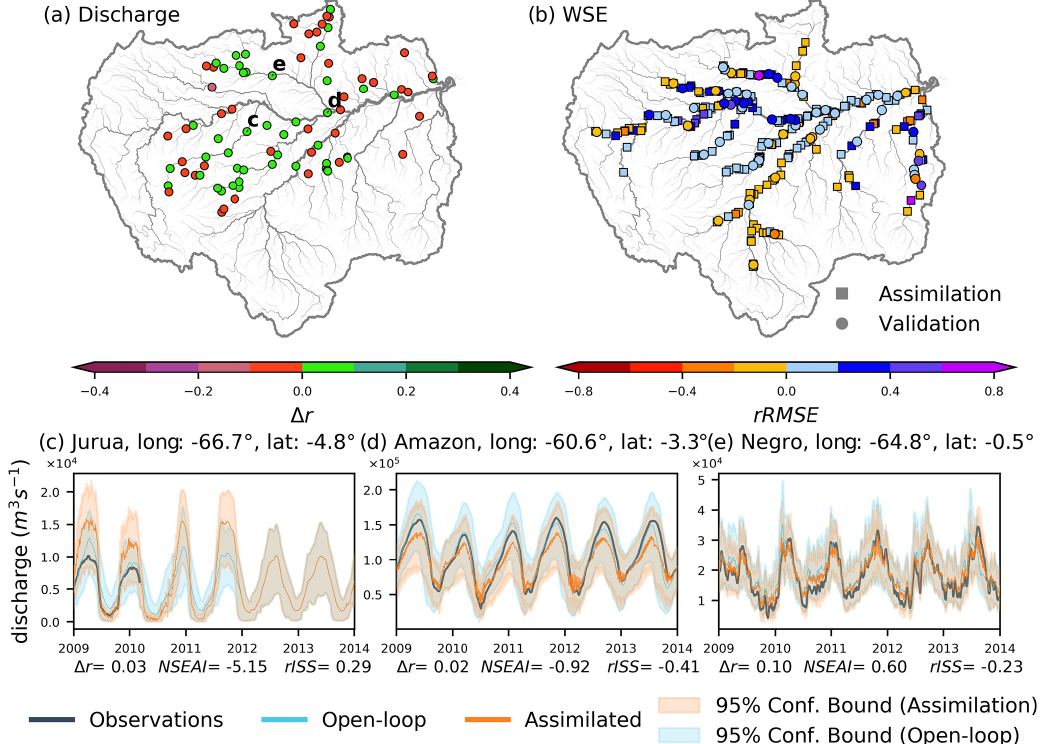
Figure 5. (a) Difference in the correlation coefficient of river discharge ( (cid:49) r) and (b) the relative root mean square error (rRMSE) in water surface elevation for ANO. Circles indicate virtual stations used for data assimilation, and squares are virtual stations used for validation on the WSE plots. Hydrographs recorded at Gaviao on the Jurua River, Manacapuru on the Amazon River, and Serrinha on the Negro River are presented in panels (c) , (d) , and (e) , respectively. The locations of the hydrographs shown in panels (c) , (d) , and (e) are presented in panel (a) . Discharge observations are shown in black, assimilated simulation results in orange, and open-loop simulation results in blue. The color range indicates the 95% confidence interval used to calculate the relative interval skill score (rISS). (cid:49) r , the Nash–Sutcliffe efficiency- based assimilation index (NSEAI), and rISS are shown at the bottom of each